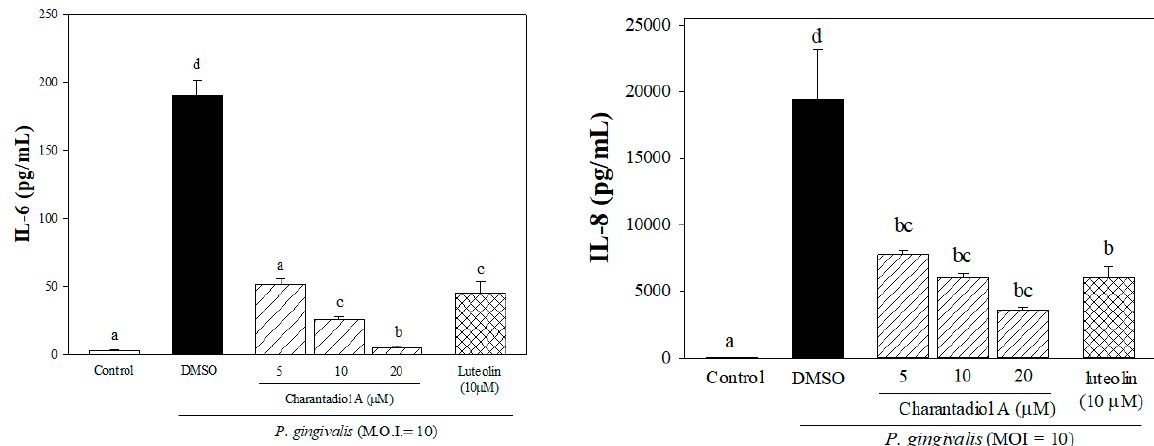
Figure 3. Effects of charantadiol A on P. gingivalis -induced pro-inflammatory cytokine production in human monocytic THP-1 cells. Cells were incubated with 0.1% ( v / v ) DMSO (as a vehicle control), or co-cultured with P. gingivalis (M.O.I. = 10) and different concentrations of charantadiol A (5, 10 or 20 µ M) for 24 h. The cell-free culture supernatants were subsequently collected and analyzed for the content of IL-8 and IL-6. Experiments were performed three times in triplicate. Each value represents the mean ± SD. Values with different letters are significantly different at p < 0.05.